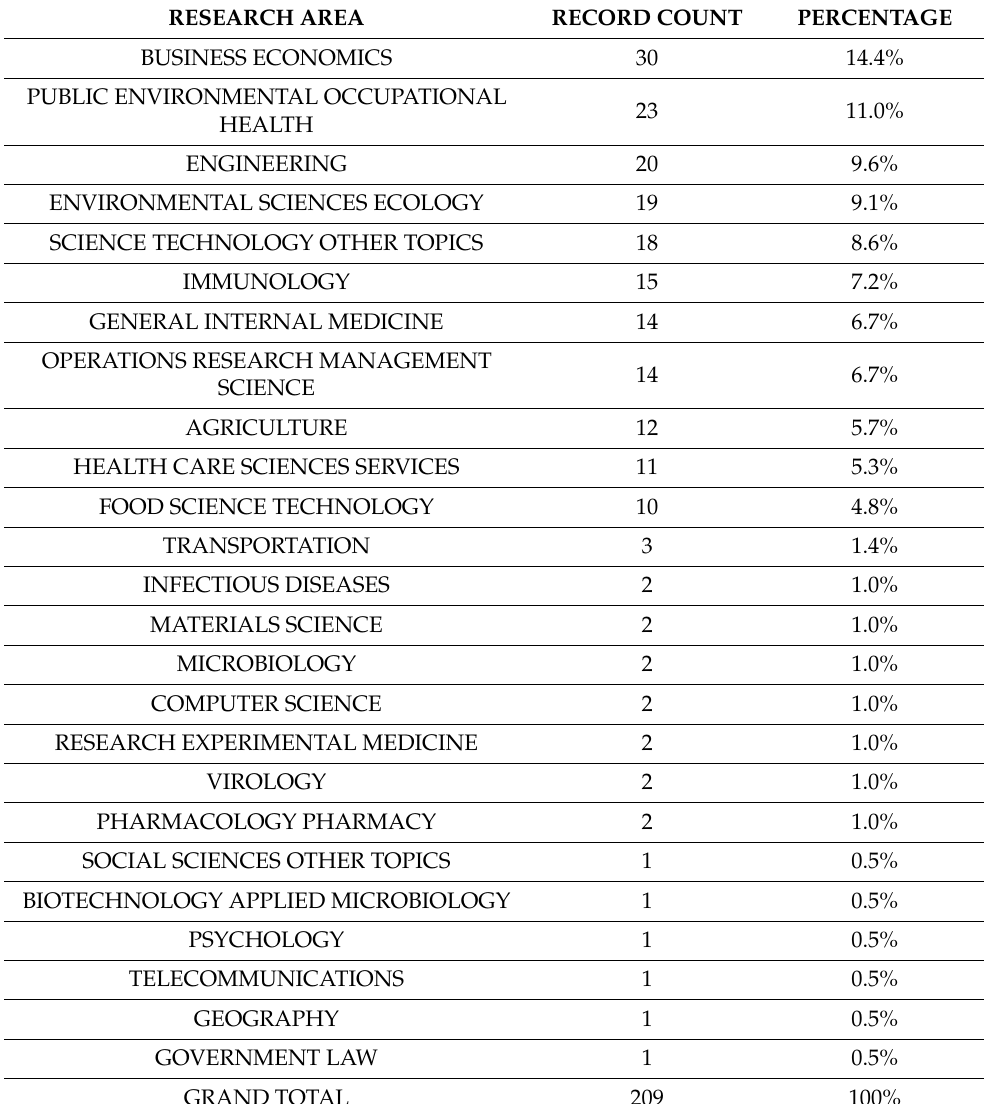
Table 3. Research Articles by